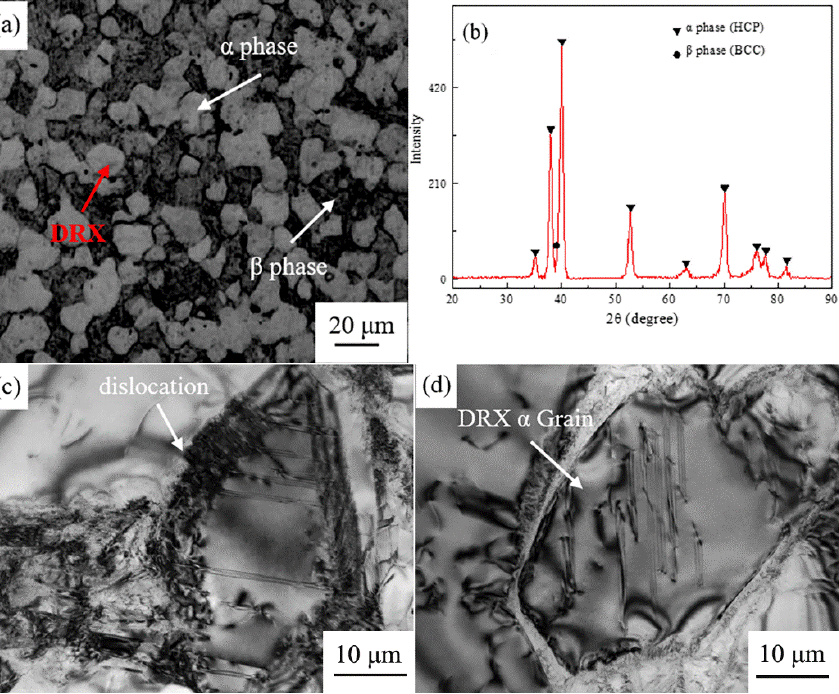
Figure 7. Microstructures of Ti-6Al-4V after superplastic deformation (T = 810 °C, = 5 × 10 − 4 s − 1 ): ( a ) optical image, ( b ) XRD spectra, ( c , d ) TEM bright-view images.